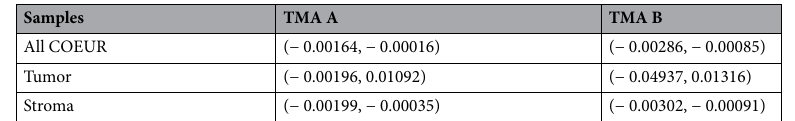
Table 3. 95% confidence intervals of the effect of CAIX on CD8 conditional on TMA from the negative binomial regression